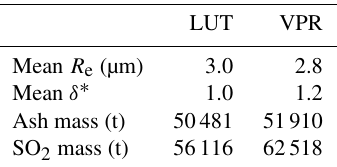
Table 6. Retrievals obtained by LUT and VPR